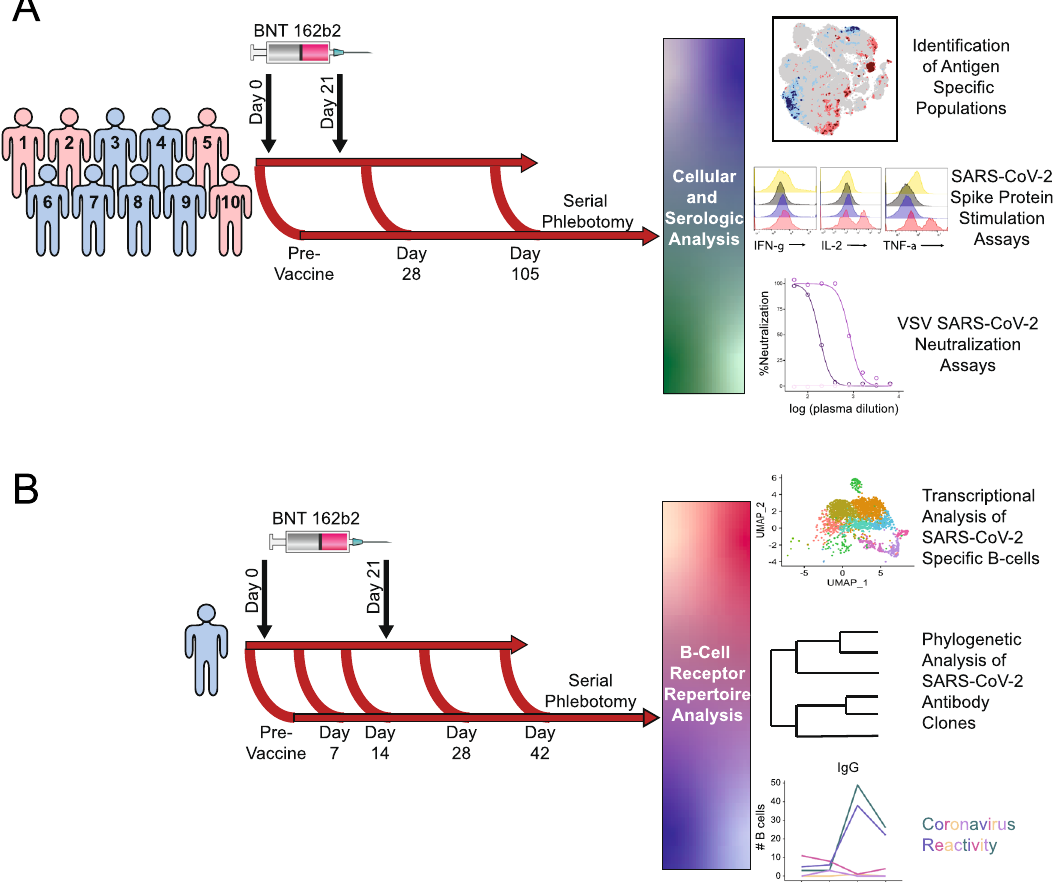
Fig. 1 Schematic of vaccination schedule and sample collection. All participants were vaccinated with BNT162b2 on days 0 and 21 and samples were collected early in 2021. A 10 healthy participants underwent serial phlebotomy that was performed pre-vaccination (day − 3 to 0), on day 28 – 30, and on day 105-108. PBMCs were isolated at each time point, and citrated plasma was stored when possible. PBMCs from these participants were utilized for CyTOF and in vitro stimulation studies. Plasma was used both for SARS-CoV-2 ELISAs and vesicular stomatitis virus pseudoneutralization assays. B A single healthy participant underwent serial phlebotomy pre-vaccination and on days 8, 14, 28, and 42. PBMCs and citrated plasma were isolated at each time point and used for transcriptional analysis of SARS-CoV-2-speci fi c B